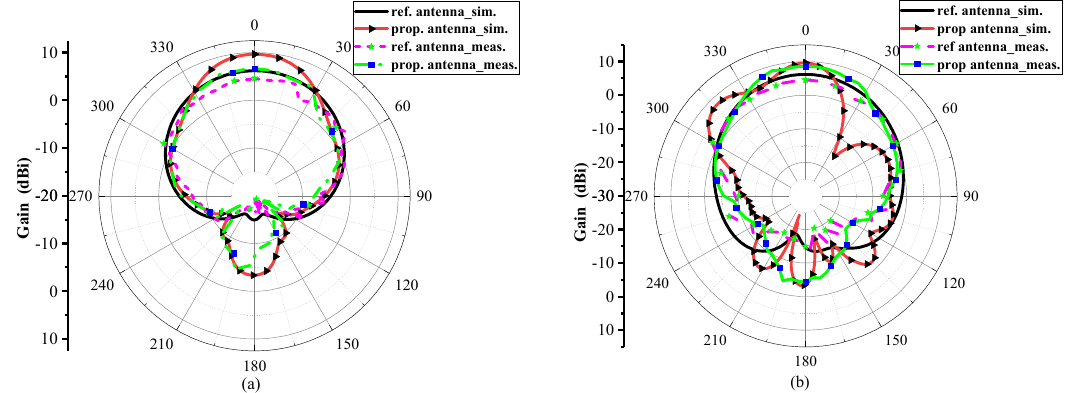
Figure 6. Measured and simulated results of radiation pattern of reference and proposed antenna at 7.6 GHz. ( a ) Measured and simulated radiation patterns in the xoz plane. ( b ) Simulated and measured results of the radiations pattern in the yoz plane.